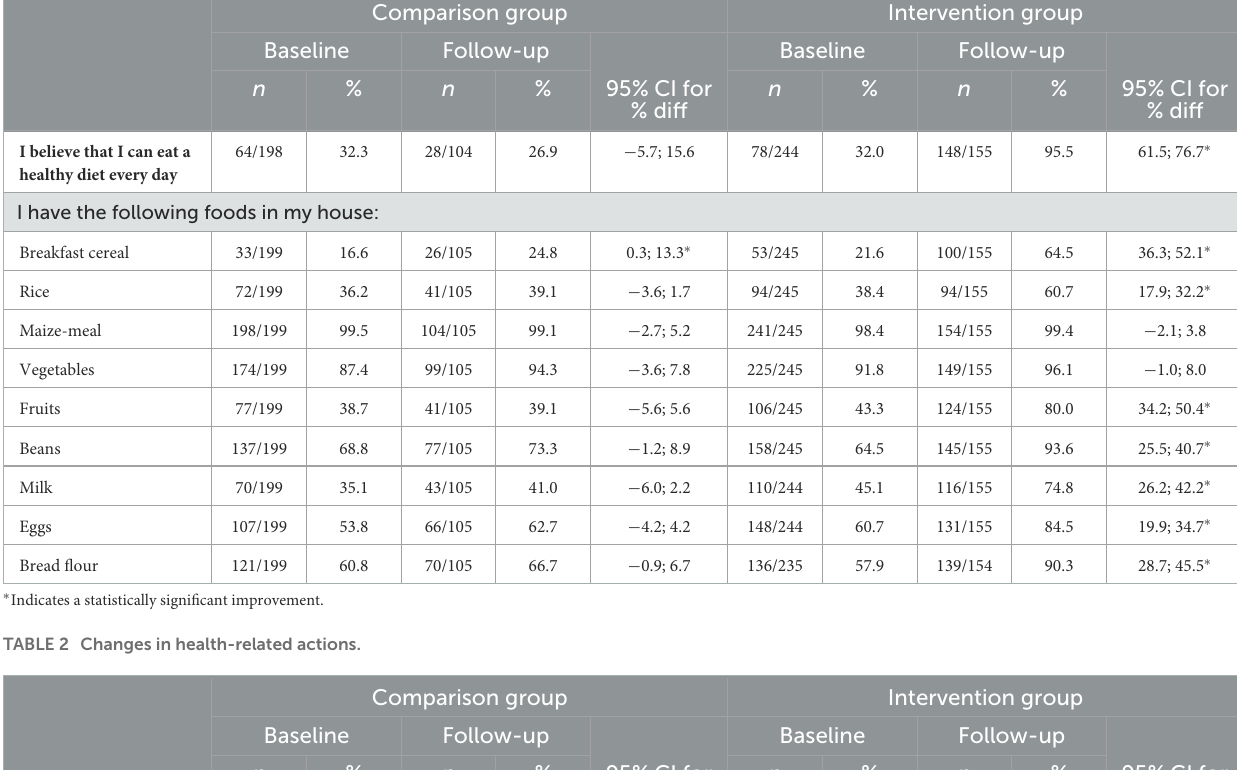
TABLE 1 Changes in nutrition-related self-efficacy. Comparison group Intervention group Baseline Follow-up Baseline Follow-up